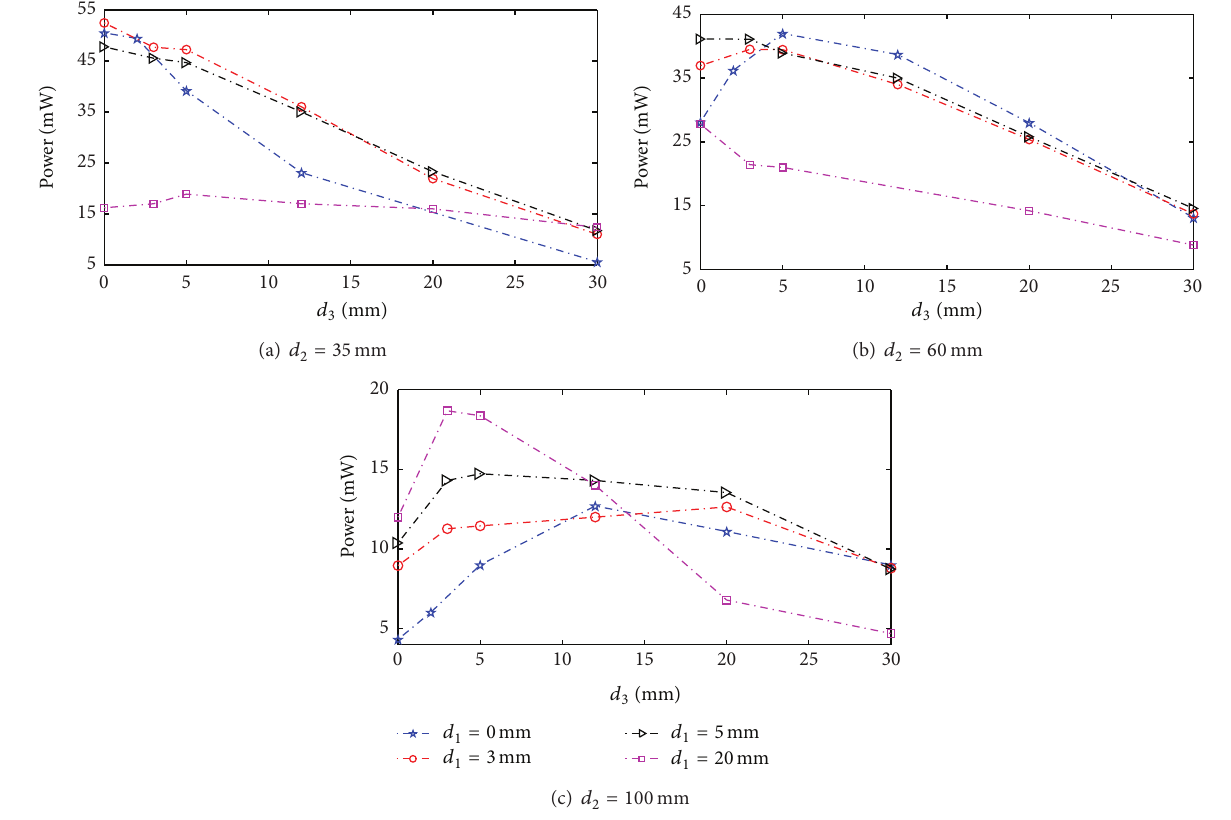
Figure 5: Variations in transmission power with separation between